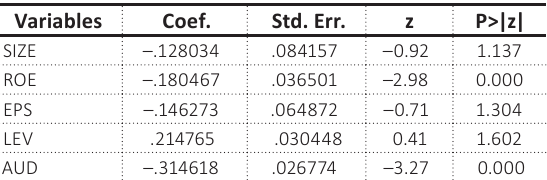
Table 3. Regression of an ordinary least